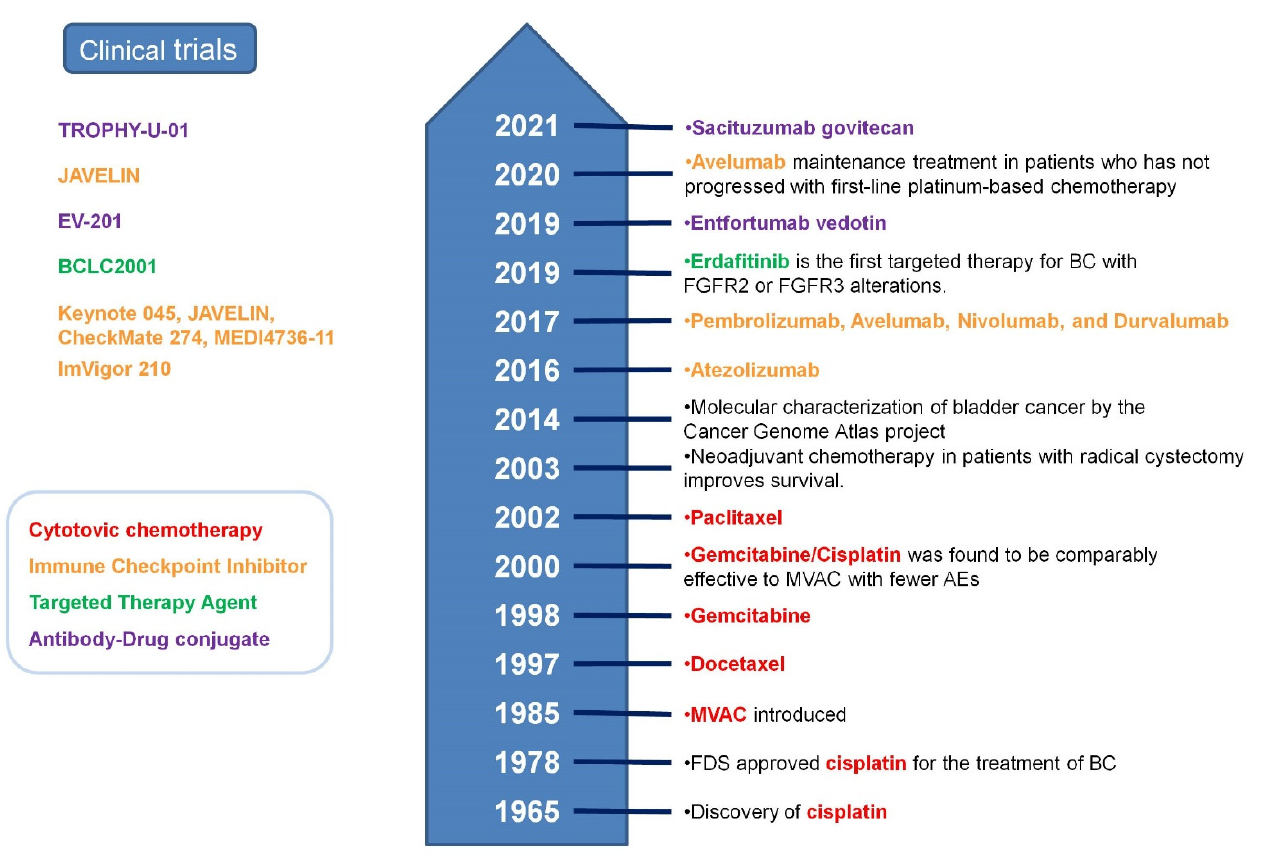
Table 1. Immuno-oncology drugs.